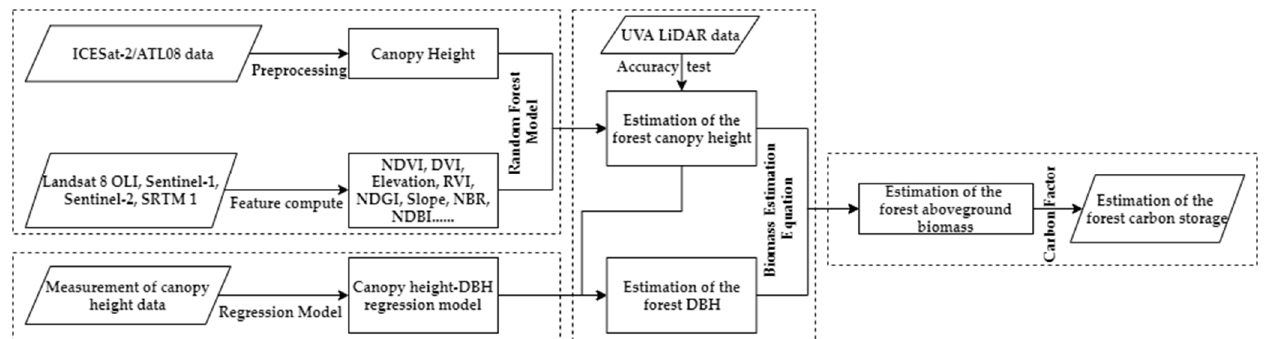
Figure 3. Flow chart of the proposed methodology for canopy height estimation and forest biomass mapping.